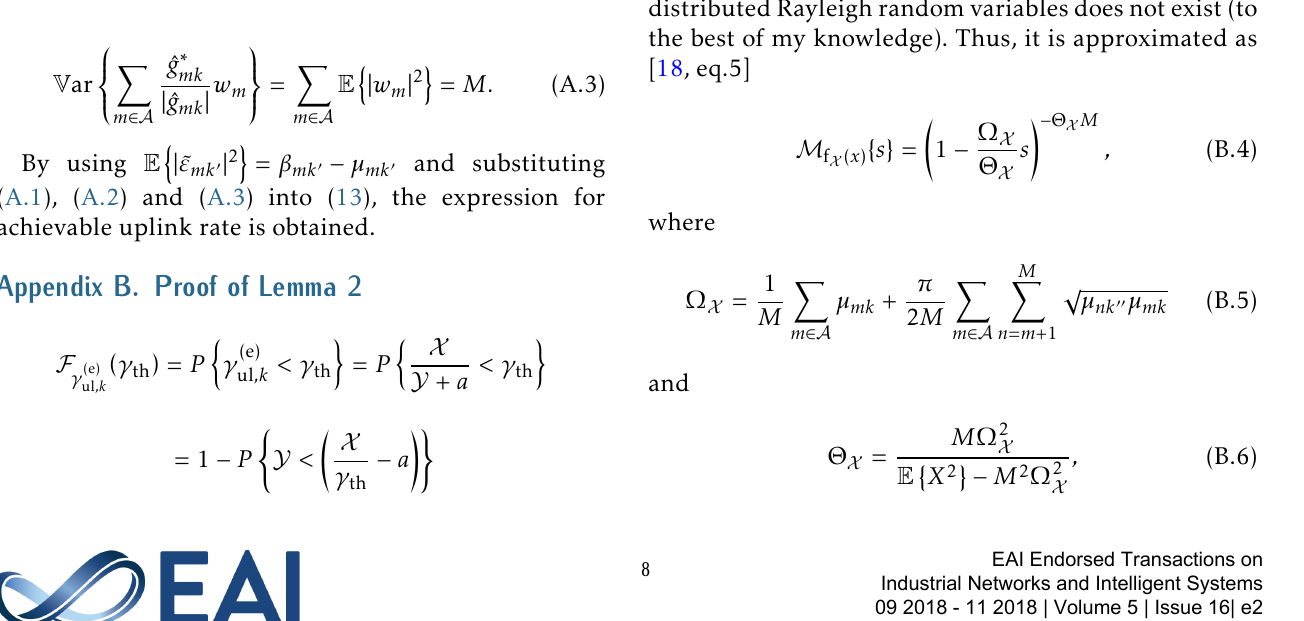
Figure 4. The cumulative distribution of the per-user uplink net throughput for the case of M = 100 and K = 20 . (4b) is the zoom